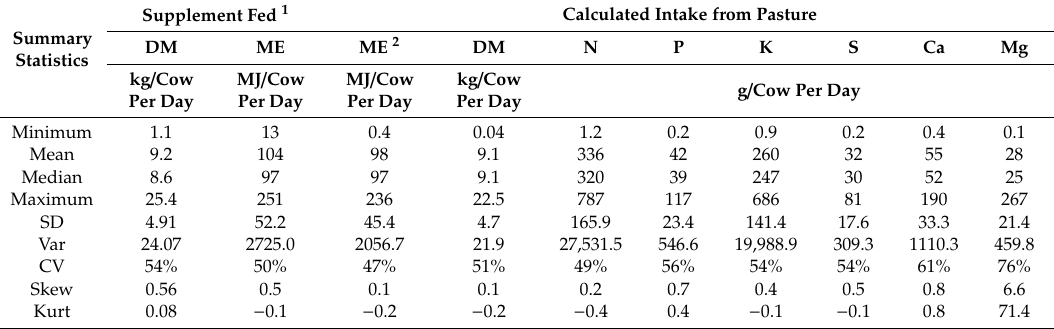
Table 4. Summary statistics for supplement dry matter (DM) and metabolizable energy (ME) fed and calculated intakes of ME, DM and nutrients from pasture of lactating herds on five occasions on 43 farms ( n = 227).